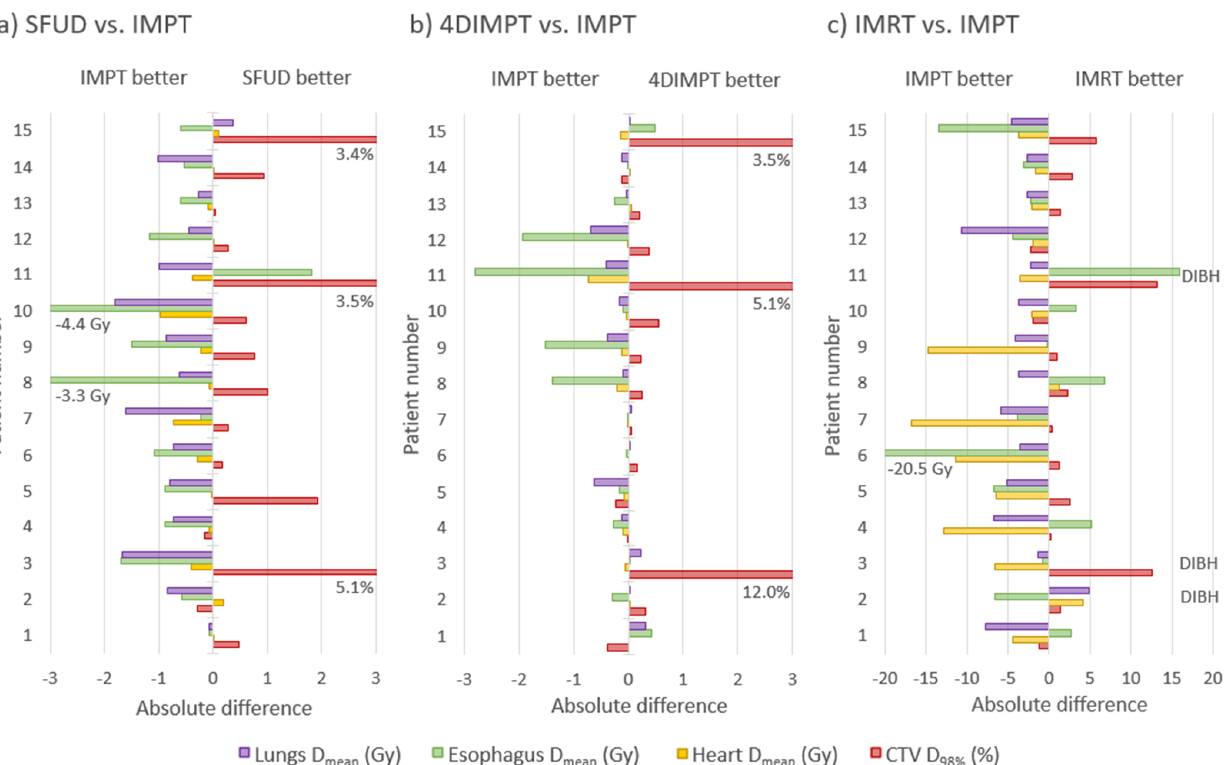
Figure 4. Absolute difference in mean OAR dose and CTV D 98% per patient between IMPT and SFUD ( a ), IMPT and 4DIMPT ( b ) and IMPT and IMRT ( c ) as calculated on the AIP at Start. Negative values are always in favor of IMPT (for the OARs, the other technique is subtracted from IMPT, while for the CTV, IMPT is subtracted from the other technique). The patients are sorted according to increasing breathing motion. Patient 1 had no primary tumor, patients 2–7 had tumor motion amplitude >0.5 cm and patients 8–15 had tumor motion amplitude <0.5 cm. Notably, the patients with a large advantage in CTV D 98% for SFUD and 4DIMPT (patients 3, 11 and 15) are the same patients where changes in breathing pattern and anatomy deteriorated CTV coverage for all proton techniques. Note also that three of the patients (2, 3 and 11) received IMRT in DIBH and cannot be directly compared in ( c ).